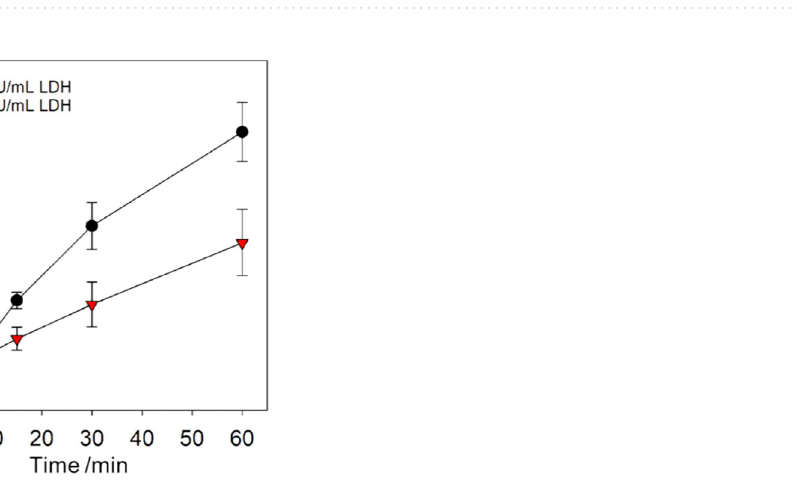
Figure 7. Concentration depending on NADH regeneration for different electrode potentials. ( a ) Percentage of active NADH depending on NAD + concentration and electrode potential; ( b ) Faradaic efficiency of 1,4-NADH regeneration depending on NAD + concentration and electrode potential.